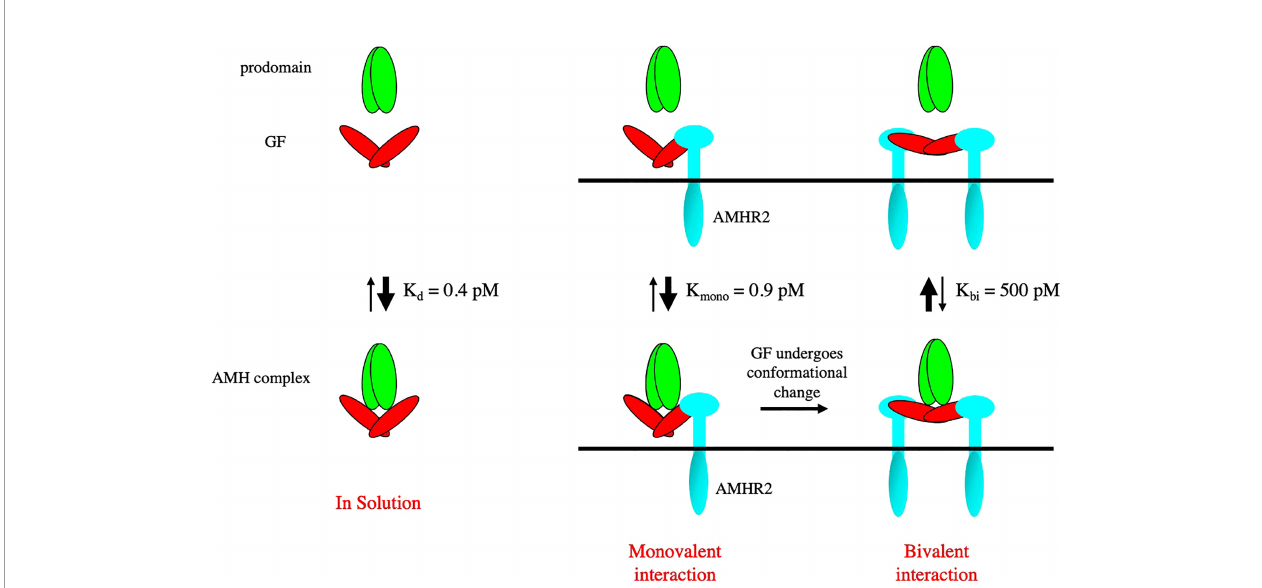
FIGURE 4 | A bivalent interaction of AMHR2 with the AMH noncovalent complex leads to a conformational change in the GF and displacement of the prodomain. The dissociation constants of the AMH complex bound monovalently and bivalently to AMHR2 are shown. Bivalent binding causes a 1000-fold increase in the K d of the complex leading to rapid